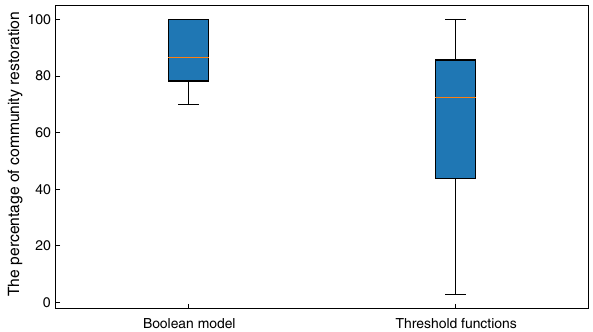
Figure 12. Box and whiskers plots illustrating the percentage of the community restoration following the restoration of the candidates identified by attractor control sets of the Boolean model. The method described in section Community restoration via attractor control was used in 1000 networks with 35 plant nodes and 25 pollinator nodes. The species identified by the control sets of the attractors that represent at least 70% of the maximal richness community were restored in the simplified Boolean model (the plot on the left) and in the original threshold functions (the plot on the right). The first quartile, median, and third quartile values are 78.26%, 86.6%, and 100% for the left box and whiskers, and 43.78%, 72.41%, and 85.71% for the right box and whiskers respectively.